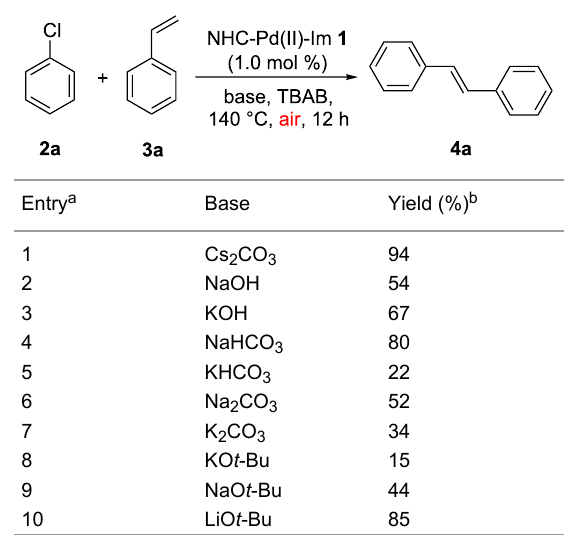
Table 1: Optimization for the NHC-Pd(II)-Im complex 1 catalyzed reac- tion of chlorobenzene ( 2a ) with styrene ( 3a